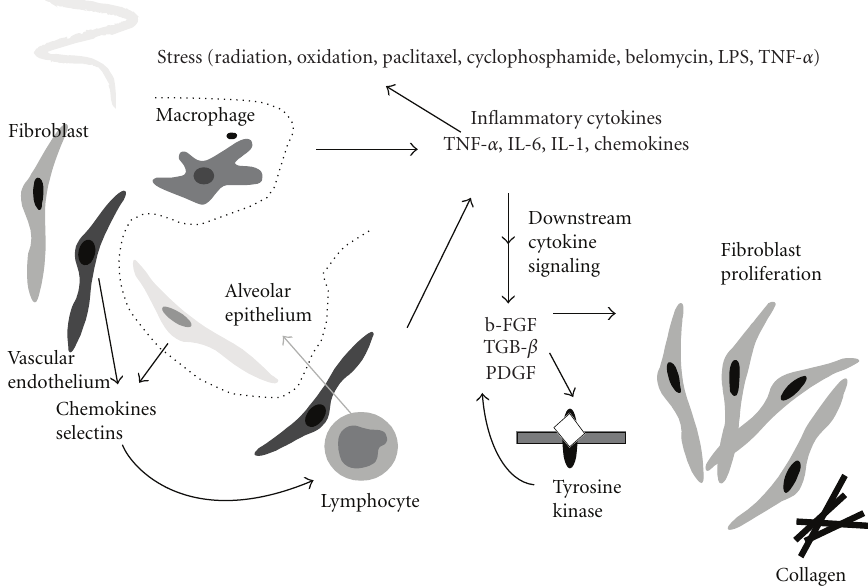
Figure 4: A schematic diagram of the possible cellular and molecular events involved in pulmonary injury by radiation. Cellular interaction among endothelial cells, alveolar epithelial cells, macrophages, lymphocytes, and fibroblasts, through cytokine mediators of chemokines, selectins, inflammatory cytokines, and fibrotic cytokines are involved (from Chen et al., Seminars in Surgical Oncology,